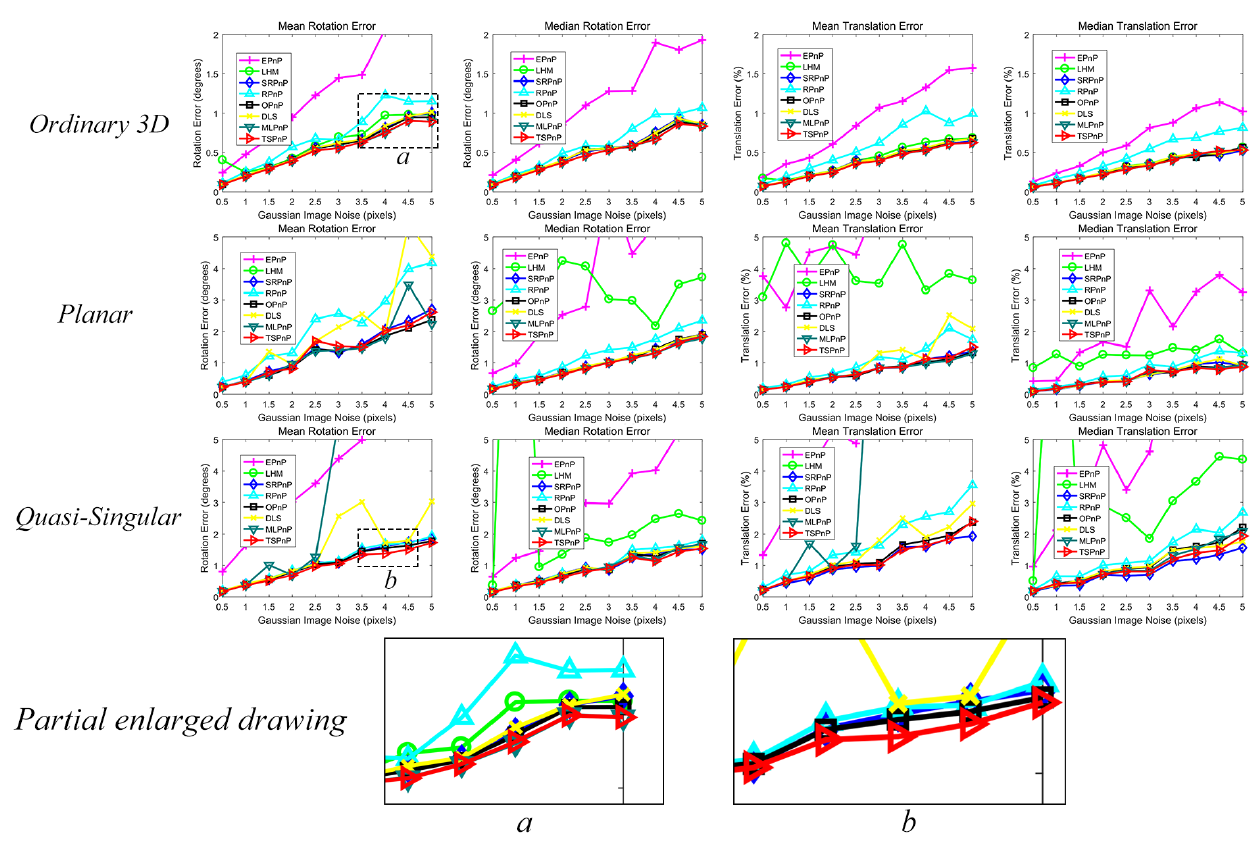
Figure 8. The rotation and translation errors under different noise of Level 1.